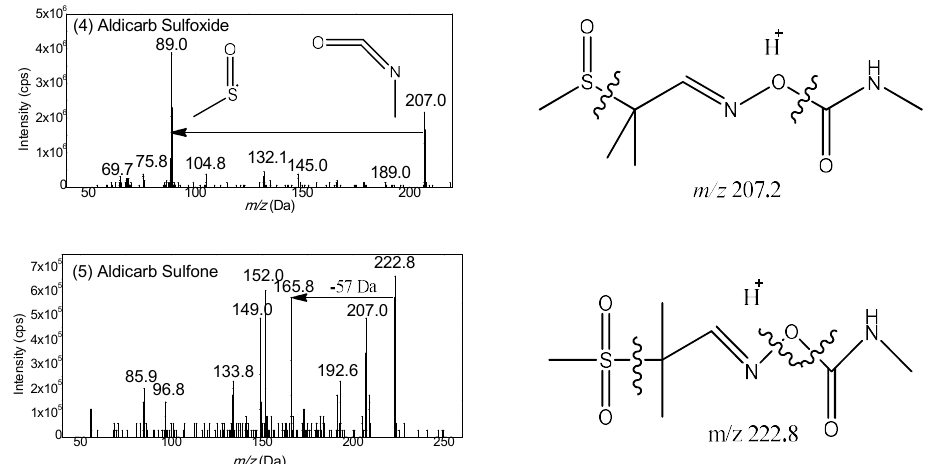
Figure 5. Product ion spectra and proposed fragmentation pathway of three N-methyl amino formic acid oxime ester: ( 1 ) Methomyl; ( 2 ) Oxamyl; ( 3 ) Aldicarb; ( 4 ) Aldicarb-sulfoxide; and ( 5 ) Aldicarb-sulfone.